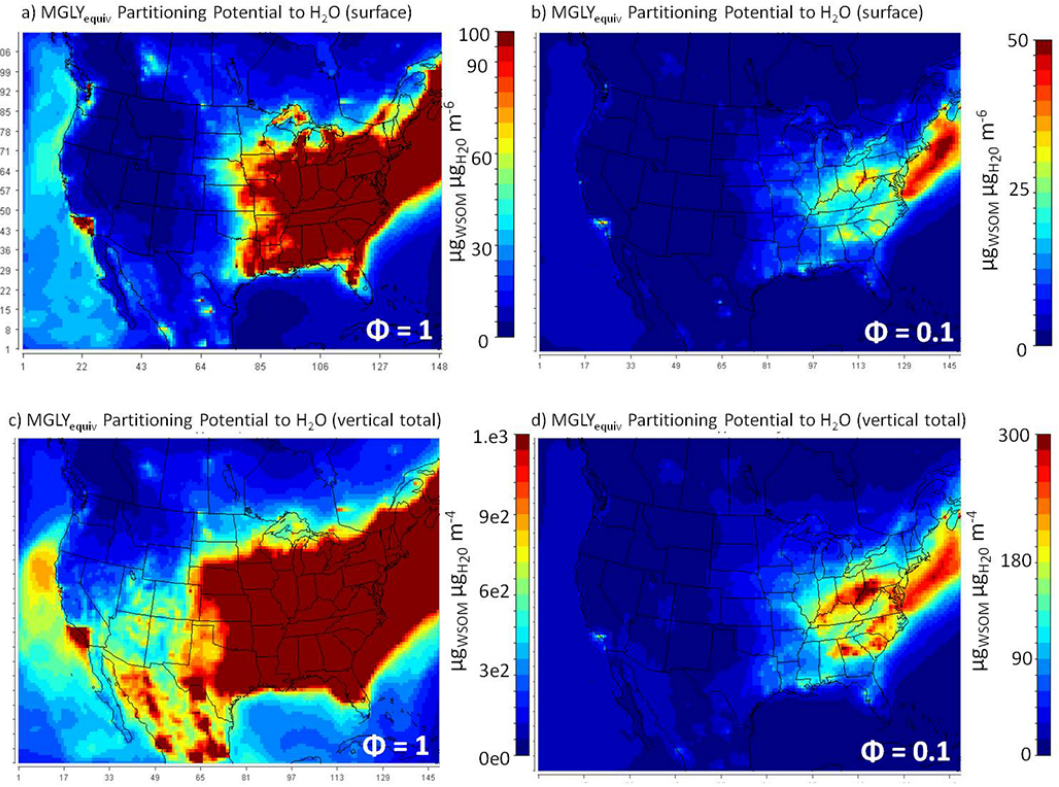
Fig. 3. CInstantaneous partitioning potential for gas-phase water-soluble organic matter (WSOM) as MGLY equiv to partition to particle phase liquid water at the surface for φ = 1 (a) and φ = 0 . 1 (b) , and for the model column (up to 100mb) for φ = 1 (c) and φ = 0 . 1 (d) . Values are July 2003